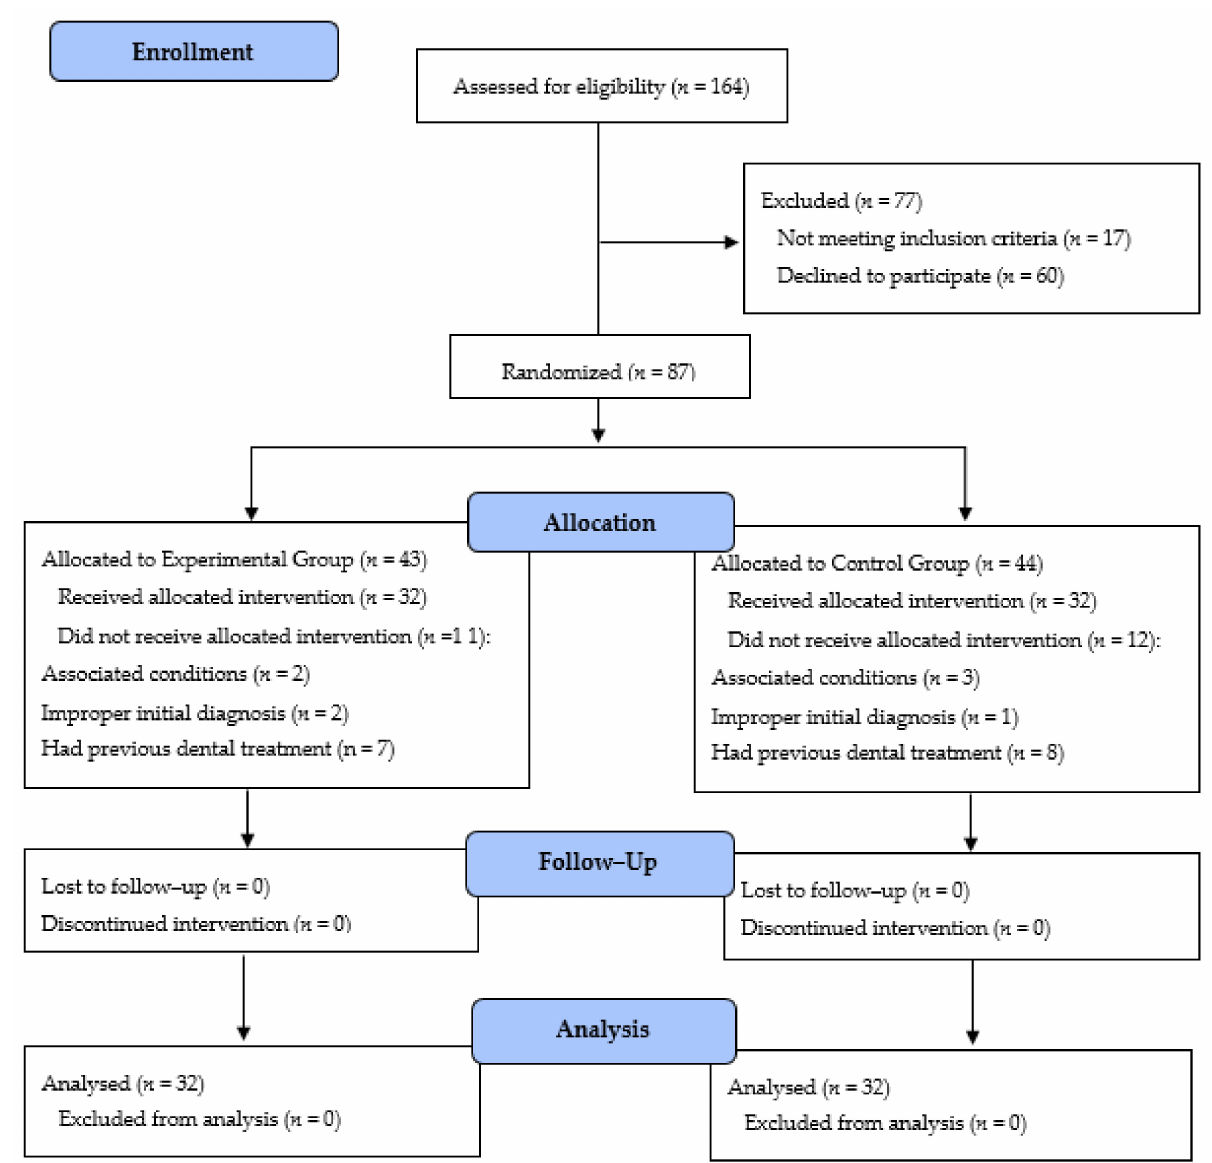
Figure 5. The CONSORT transparent reporting of trials. n : number of children with